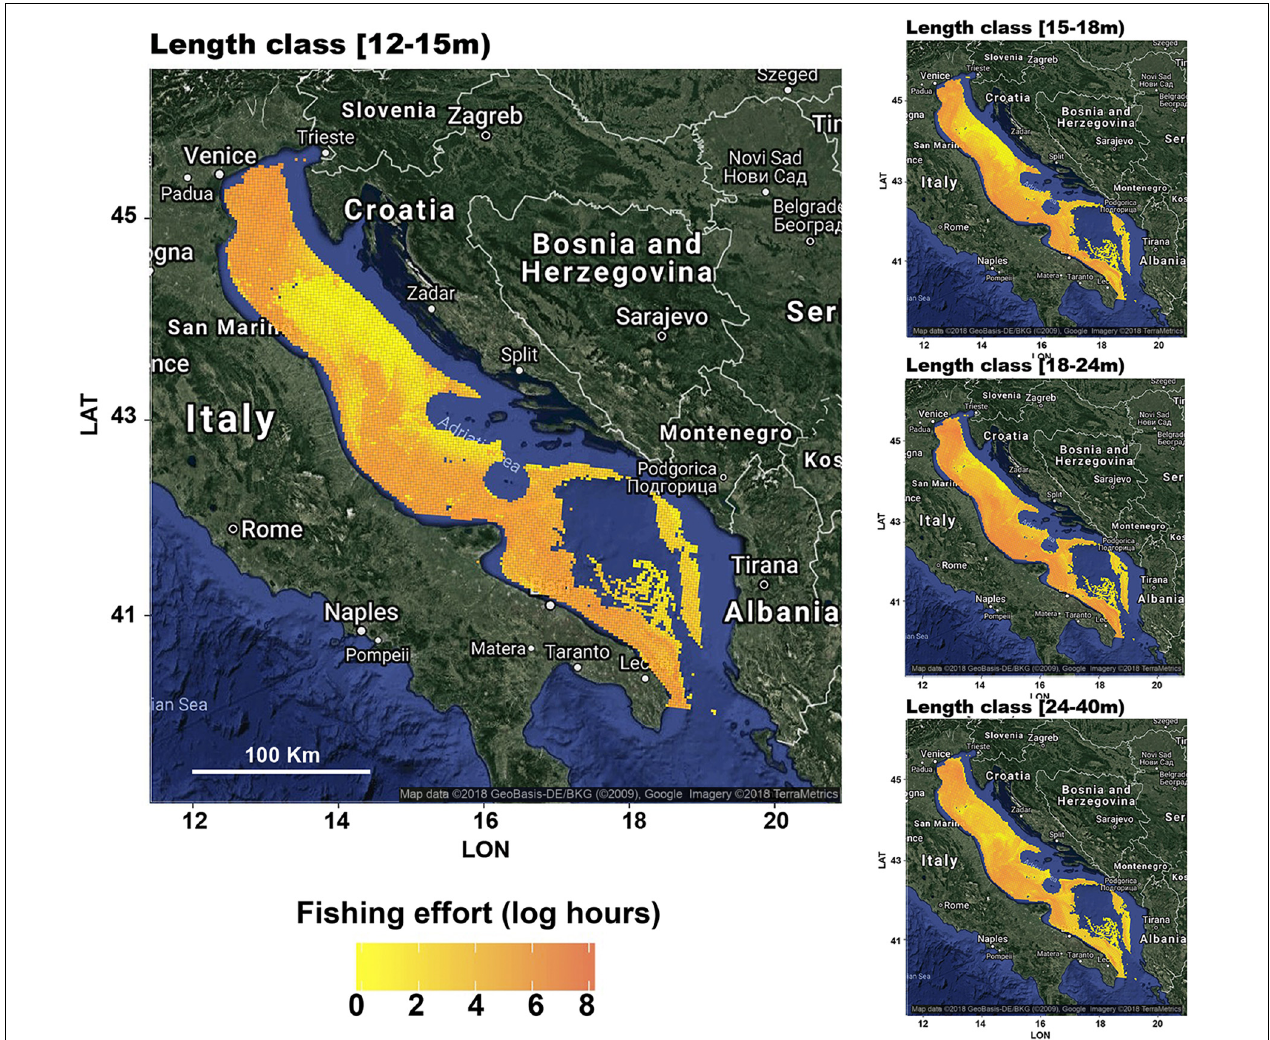
FIGURE 9 | Fishing footprints as the total yearly fishing efforts (means of the years 2012–2016) estimated from CMPN 10 − 8 , for the four different length classes that group the Italian trawlers operating in the Adriatic Sea. Particular emphasis is given to the length class [12–15 m). The effort scale is the same for the four subfigures to provide comparability. The figures were created using the R package ggmap (Kahle and Wickham, 2013) importing images from Google